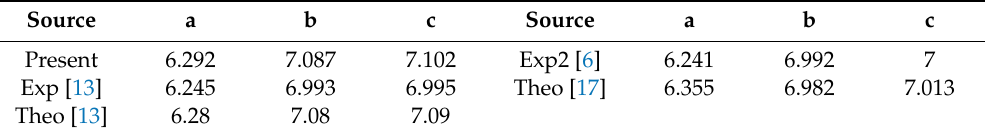
Table 3. Comparison of lattice parameters of anhydrite (unit: Å).